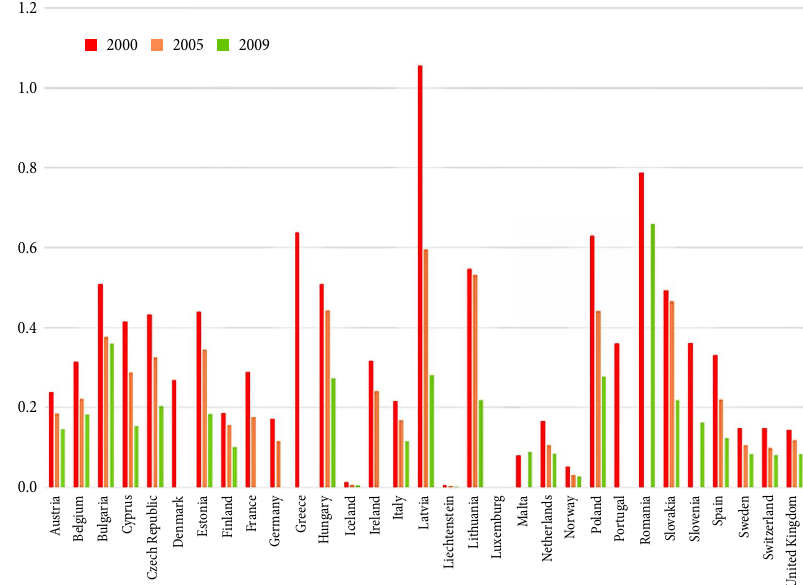
Fig. 1. Time series of fatal road accidents per capita ratio by countries (please note that only 2000, 2005 and 2009 were visualized in order to keep the resolution of figure)